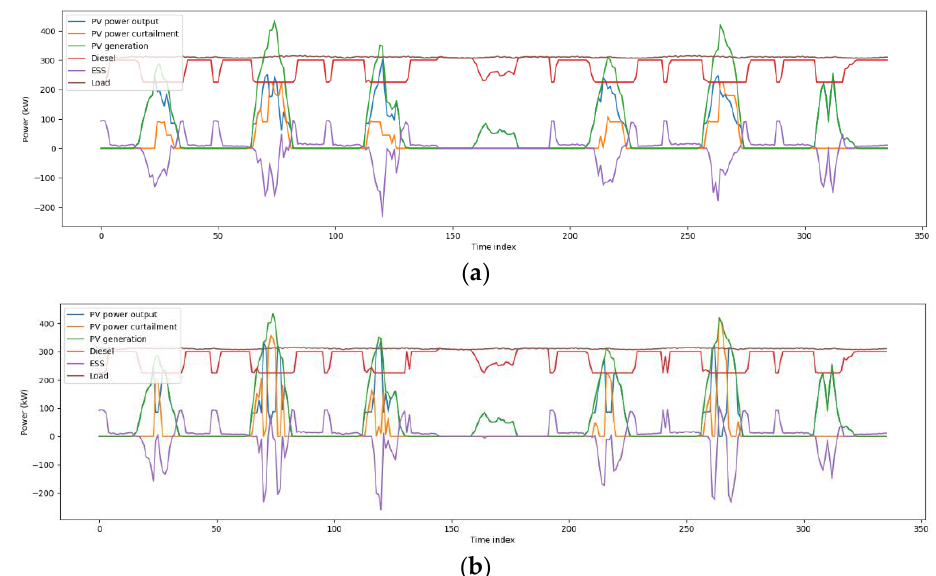
Figure 10. Simulation results of proposed method ( a ) and conventional method ( b ) for 7 days of December.